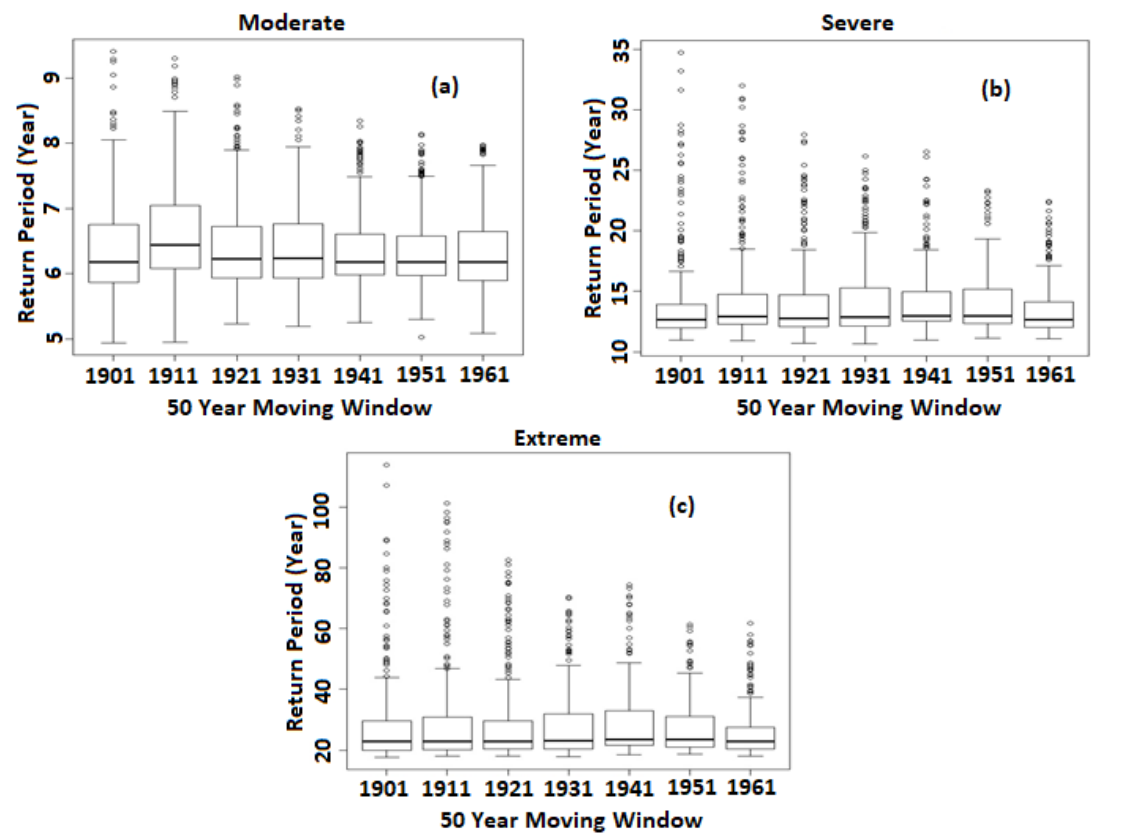
Figure 8 . The number of grid points at which significant changes in ( a ) precipitation, ( b ) mean temperature, and ( c ) SPEI during rice-growing season for different 50-year windows during 1901– 2010.